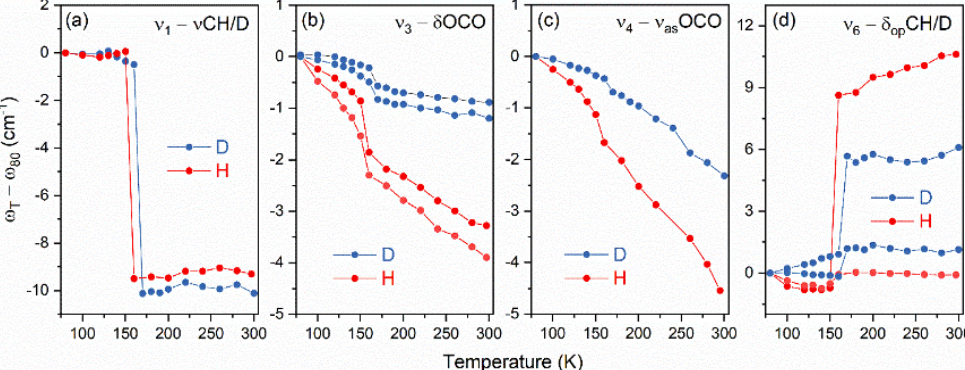
Figure 4. The temperature dependencies of ν 1 ( a ), ν 3 ( b ), ν 4 ( c ), and ν 6 ( d ) bands observed for deuterated (D, blue) DMAZnD and non-deuterated (H, red) analogues [35]; ( a , b , d ) presents Raman bands and ( c ) presents IR bands.